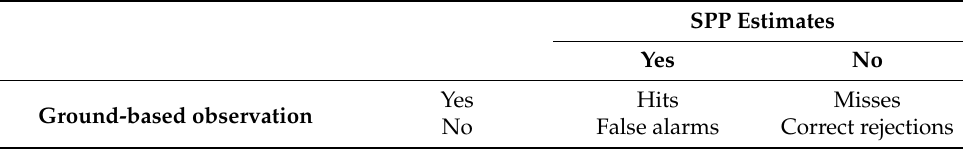
Table 2. Contingency table for the definition of hits, misses, and false alarms that used in Equations (3) and (4). The precipitation rate in ground-based observation or satellite precipitation product (SPP) greater than the selected criteria are indicated as “Yes”, otherwise